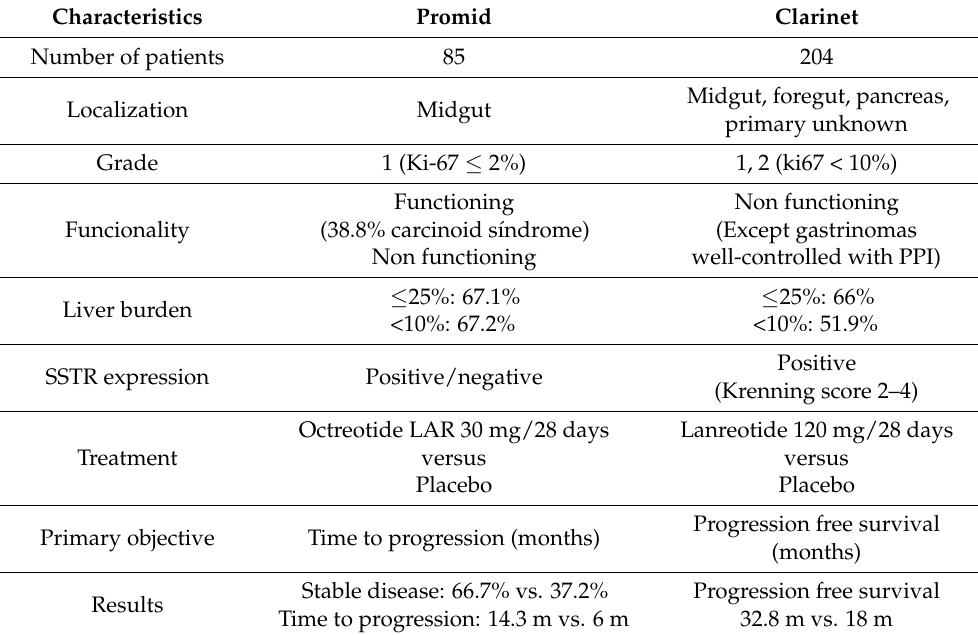
Table 2. Comparison between PROMID and CLARINET studies. PPI: proton pump